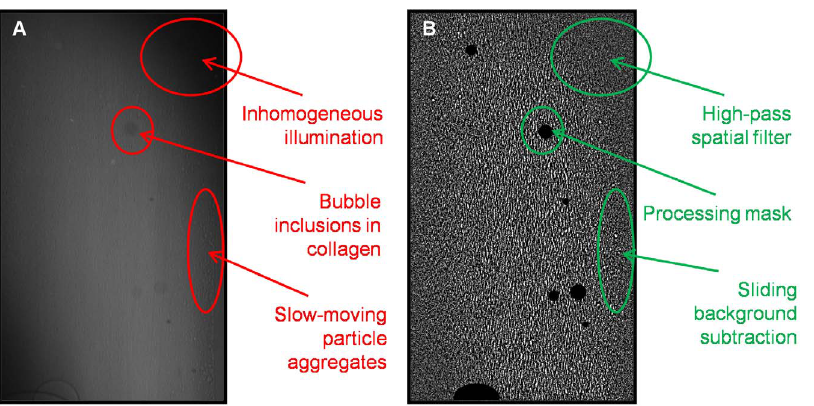
Figure 3. Sample images of blood flow in the collagen microchannel. A: Raw image after reorientation and cropping to vessel diameter. B: Processed image (sliding mean background subtraction, high-pass filter, and mask). Image B has been brightness- and contrast-enhanced for visualization.